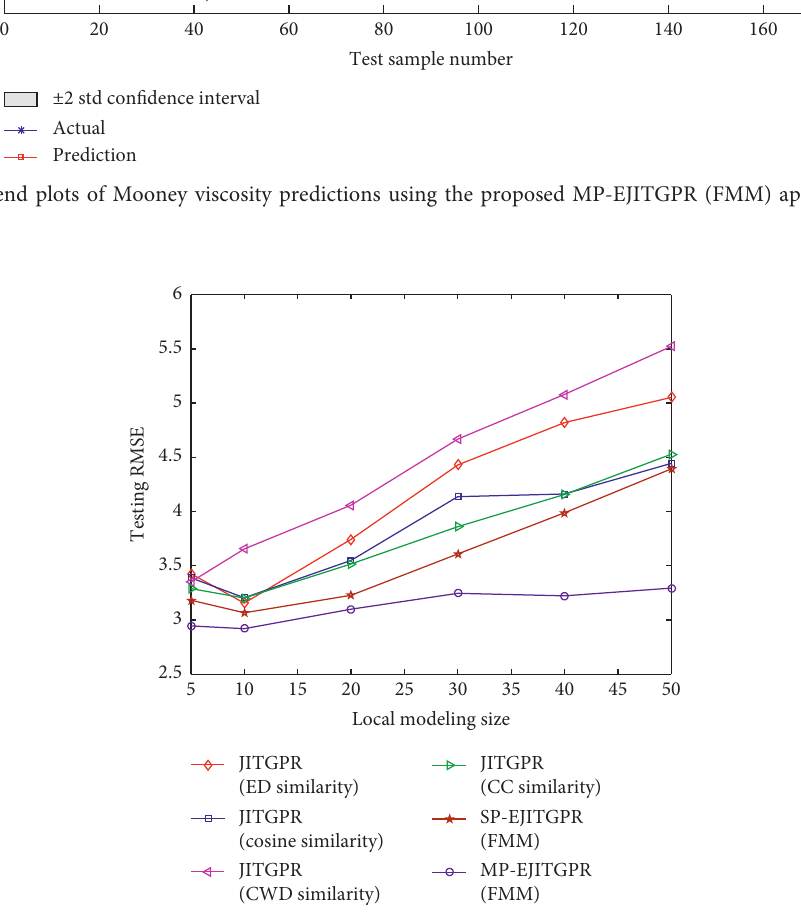
Figure 5: Comparison of prediction performance using single and ensemble JITGPR